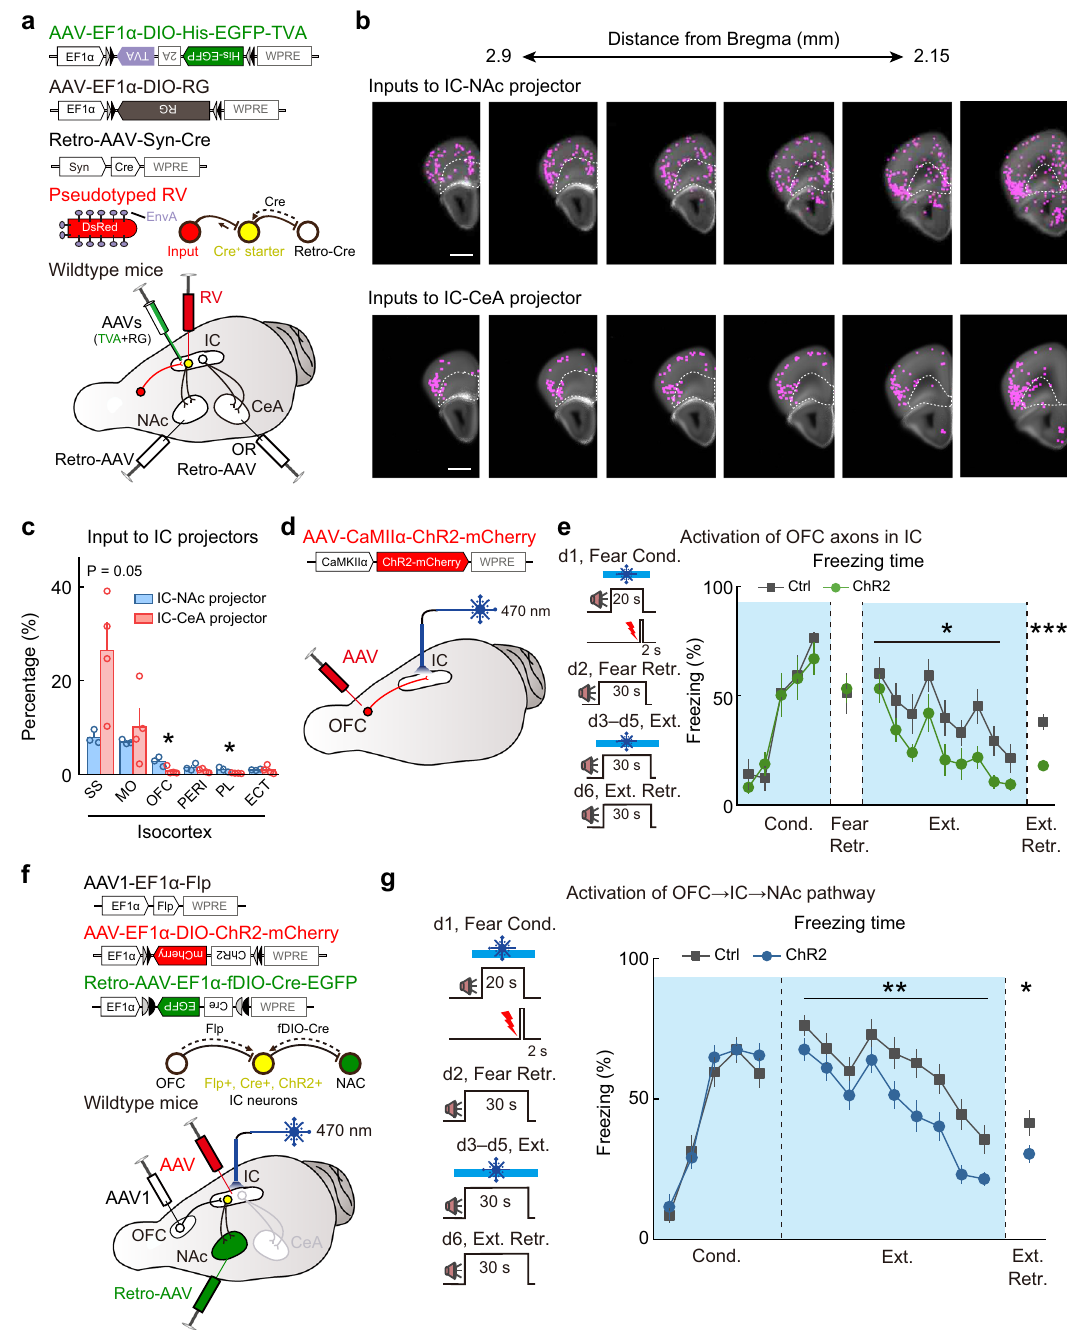
Fig.7|ActivationofOFC → IC → NAcpathwaypromotesextinctionlearningand memory. a – c Whole-brain mapping of monosynaptic inputs to IC projectors. a Viral injection strategy. b Distributions of RV-labeled input neurons. Each dot represents one RV-labeled neuron. White-dashed curves denote outlines of OFC. Scalebar,1mm. b WascreatedwithMatlab(R2014a,USA,https://www.mathworks. com) by aligning fl uorescence imaging to the fully open-access corresponding coronalsectionofAllenMouseBrainAtlasandAllenReferenceAtlas-MouseBrain. Allen Mouse Brain Atlas, mouse.brain-map.org and atlas.brain-map.org. c Quanti fi cation of labeled monosynaptic inputs to IC projectors. IC-NAc